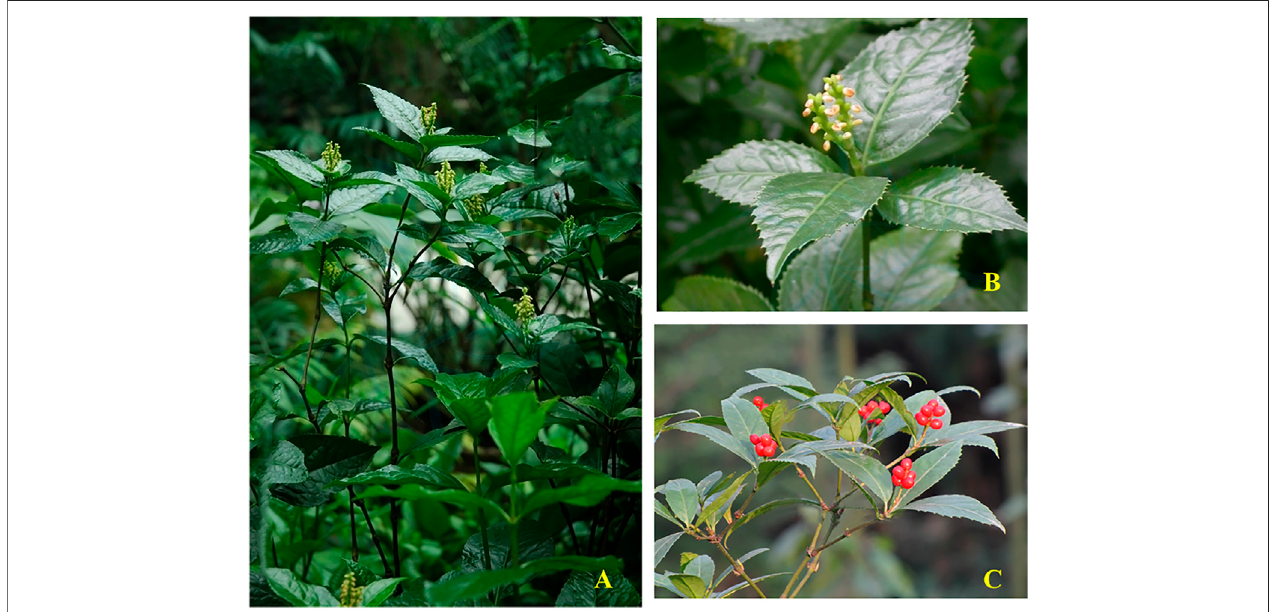
FIGURE 2 | Sarcandra glabra. (A – C) represent the whole plants (A) , in fl orescence (B) and fruits (C) of S. glabra .